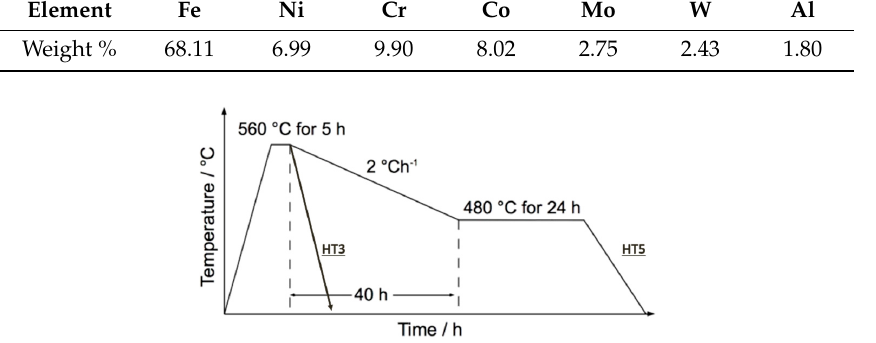
Figure 1. Schematic of the two ageing heat-treatments.